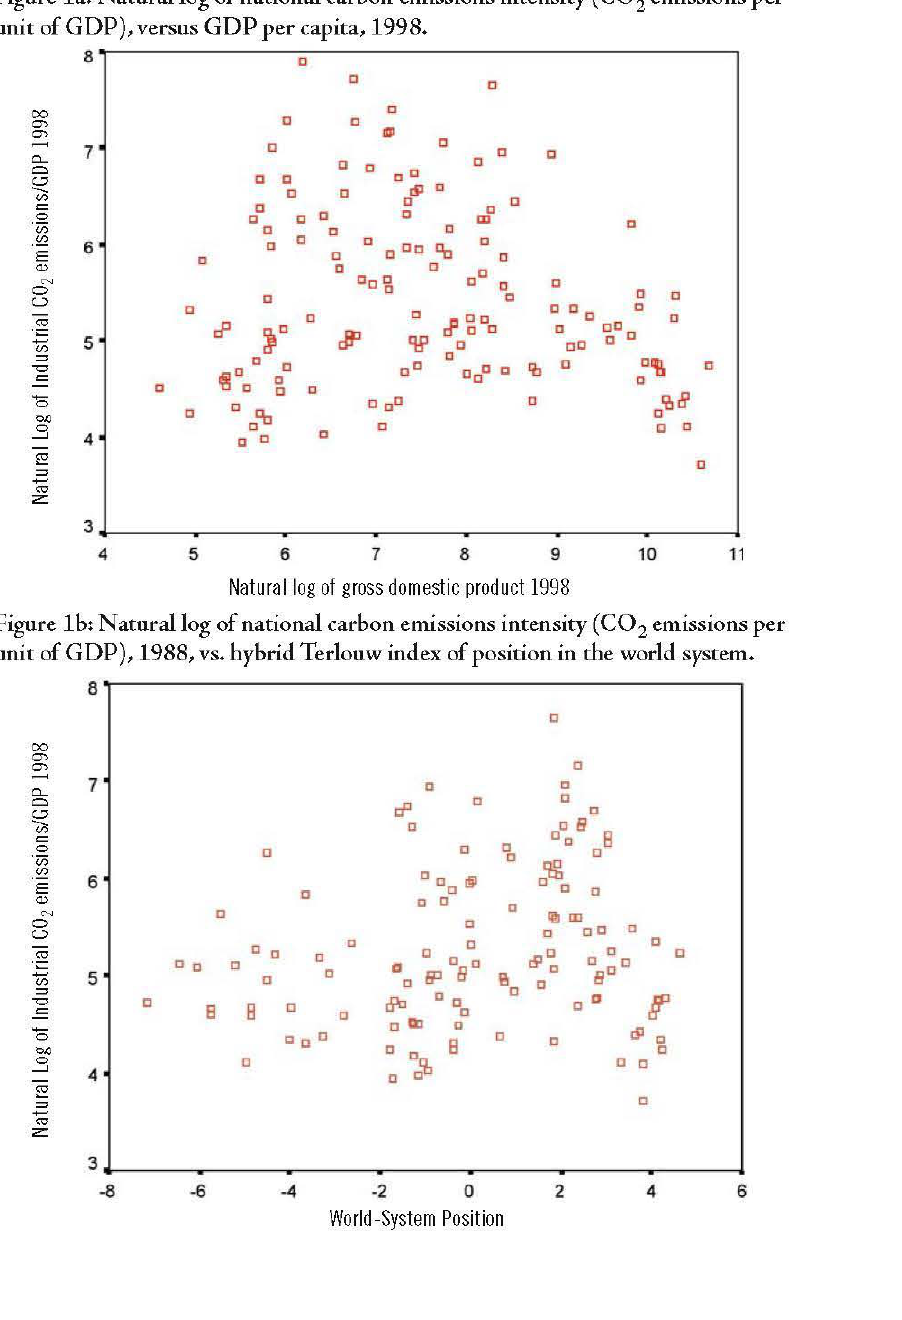
emissions per 2